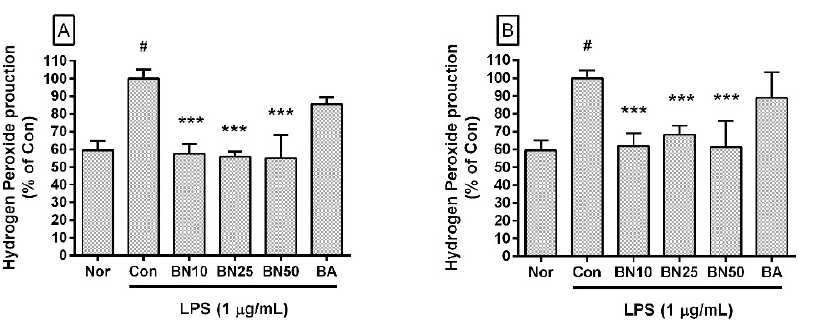
Figure 3. Effect of baicalin treatment of RAW 264.7 cells on hydrogen peroxide production. Macrophages were treated for 24 h ( A ) and 48 h ( B ). Values are presented as mean ± SD of three independent experiments. Nor, normal group incubated with media only; Con, control group treated with 1 µ g/mL of LPS only; BN10, BN25, and BN50 are 10, 25, and 50 µ M of baicalin, respectively; BA, baicalein (25 µ M). # p < 0.05 vs. Nor; *** p < 0.001 vs. Con.